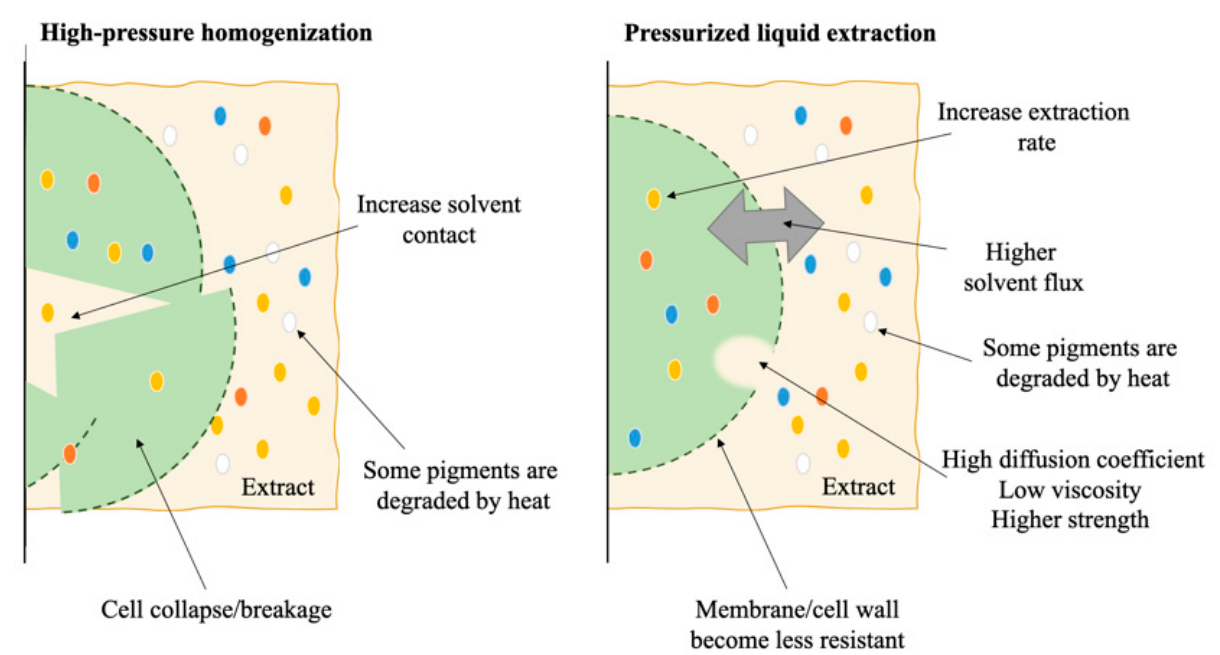
Figure 3. Schematic representation of high − pressure homogenization (HPH) and pressurized liquid extraction (PLE) effects in microalgae and cyanobacteria cells.